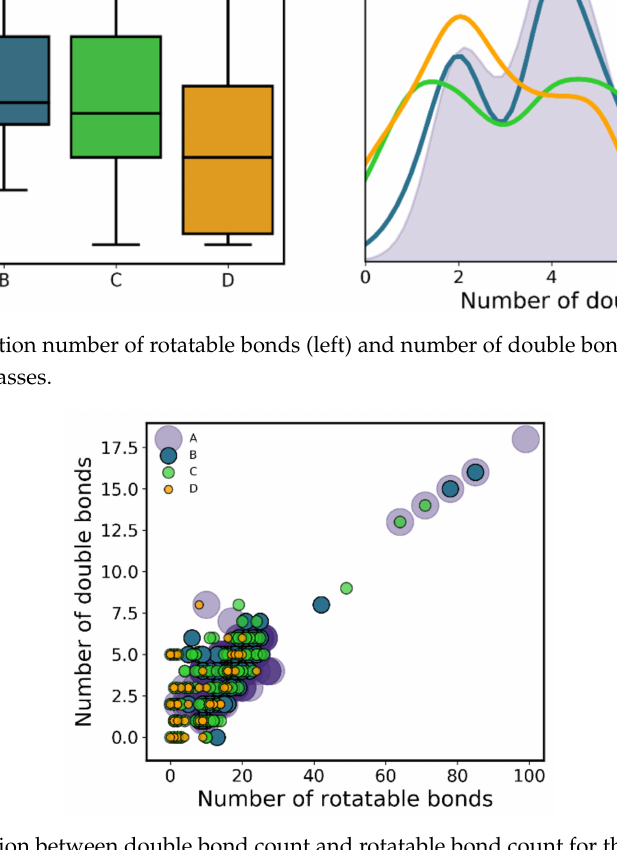
Figure 13. Correlation between double bond count and rotatable bond count for the full dataset. Each point corresponds to a compound, as it is colored by the compound’s class